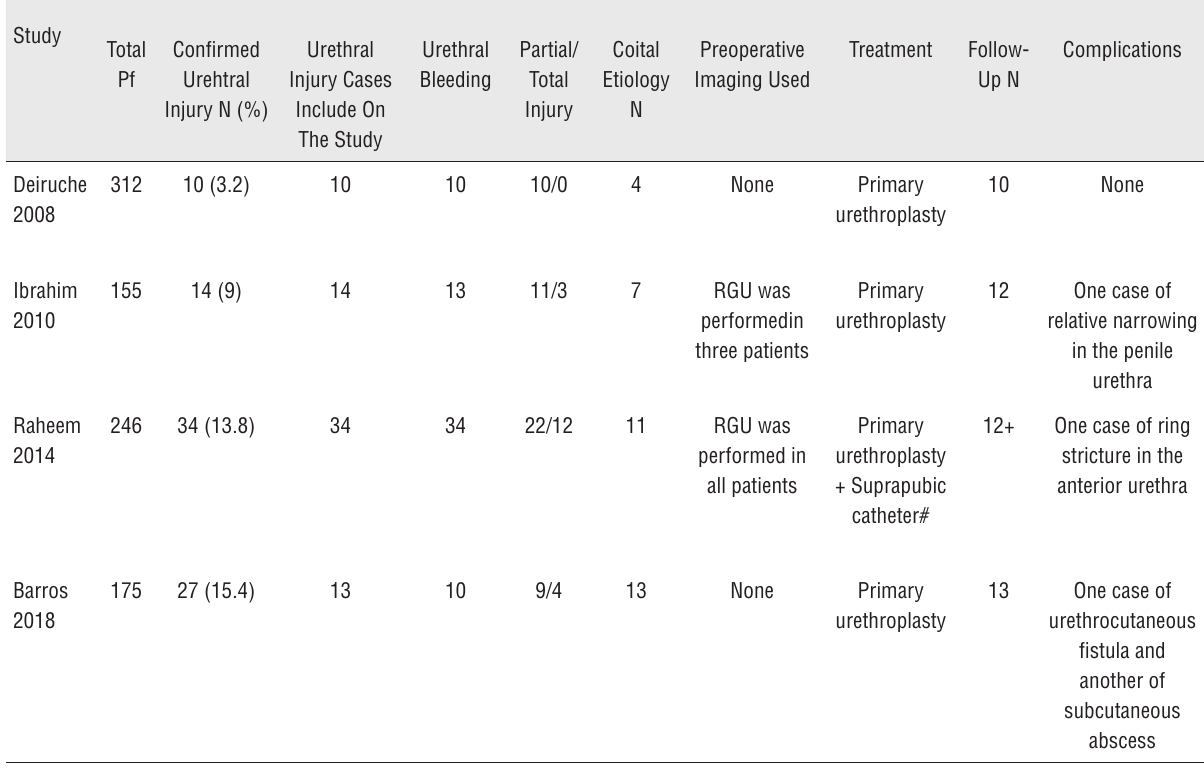
Table 1 – Findings of urethral injury in penile fracture and outcomes from selected series.